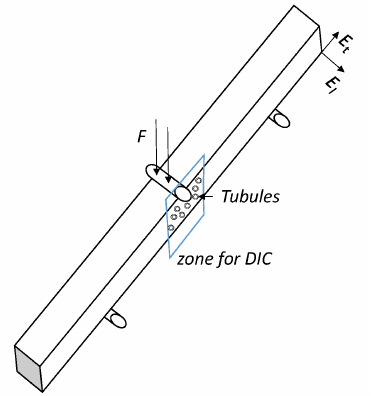
Figure 5. Three-point bending test under the optical